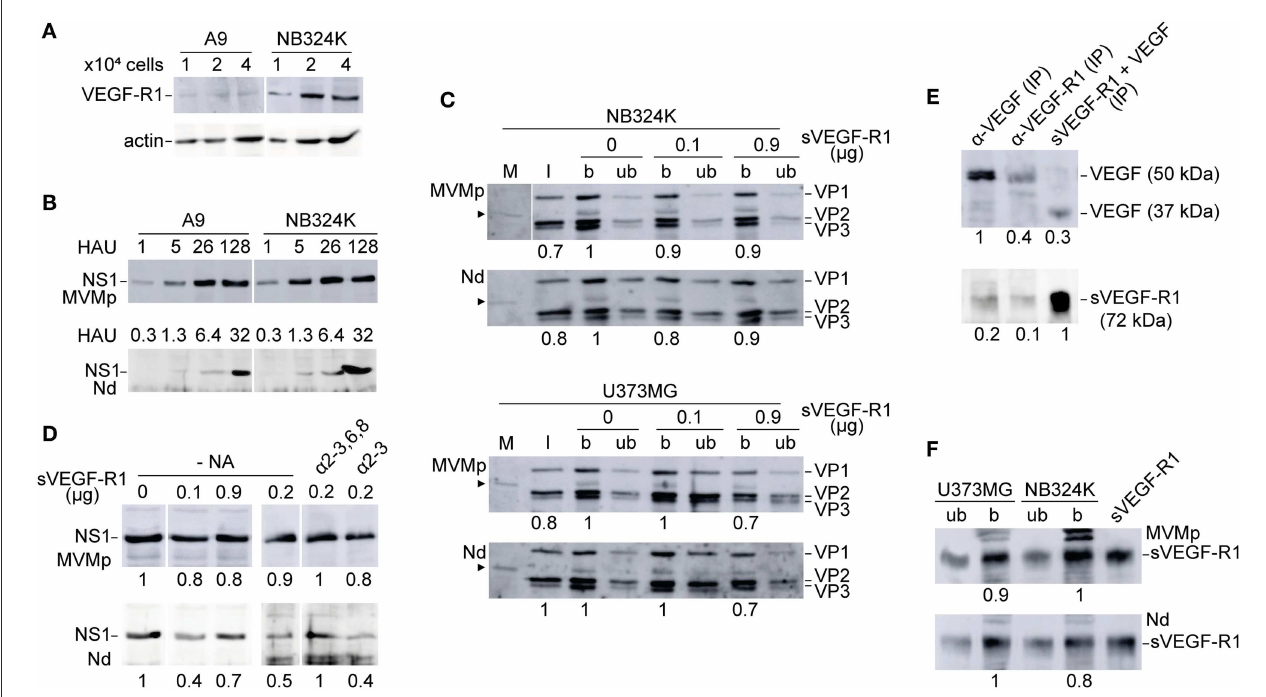
FIGURE4 Analysis of the use of VEGF-R1 by the MVMp and MVM-Nd virions. (A) VEGF-R1 expression levels in MVMp permissive mouse and human fibroblasts demonstrated by anti-VEGF-R1 polyclonal antibody (Reliatech, 1/200) in WB. (B) NB324K/A9 relative infection capacity of the MVMp and MVM-Nd viruses analyzed by NS1 expression at 20 hpi. The number of HAU of purified virions inoculated per 10 5 cells is outlined. (C) Binding analysis of density purified viral particles to NB324K ( upper ) and U373MG ( lower ) cells in the presence of the indicated amounts of sVEGF-R1 and 5x10 11 viral particles added to 10 5 cells during virus adsorption. Panels show the viral structural proteins (VP1, VP2, VP3) detected by WB in bound (b) and unbound (ub) samples. Arrowhead marks a VP-related protein present in all cultured cell samples presumably originated from the calf serum. M, Mock; I, input virion. (D) NS1 expression in NB324K cells upon virus adsorption in the presence of the indicated amounts of sVEGF-R1 performed as in (C) . Right: Similar NS1 expression analysis but following binding at 4 ◦ C in the presence of sVEGF-R1 previously incubated at 37 ◦ C with 0.05 U/ µ l of α -2-3 and 0,3 U/ µ l of α -2-3,6,8 sia cleaving neuraminidases. Shown are WB performed at 20 hpi. (E) VEGF/sVEGF-R1 interaction (5ng/ml each, overnight at 4 ◦ C) analyzed by IP-Sepharose and WB with specific antibodies. (F) Control detection of sVEGF-R1 by WB (Reliatech, 1/200) in the b and ub samples shown in (C) performed at the higher doses (0.9 µ g) of sVEGF-R1. Numbers below the panels are relative arbitrary units (a.u.) of densitometry.